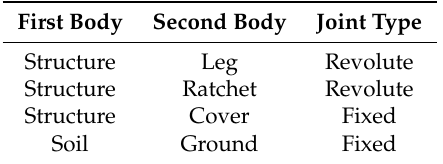
Table 3. Joint type used between each pair of rigid